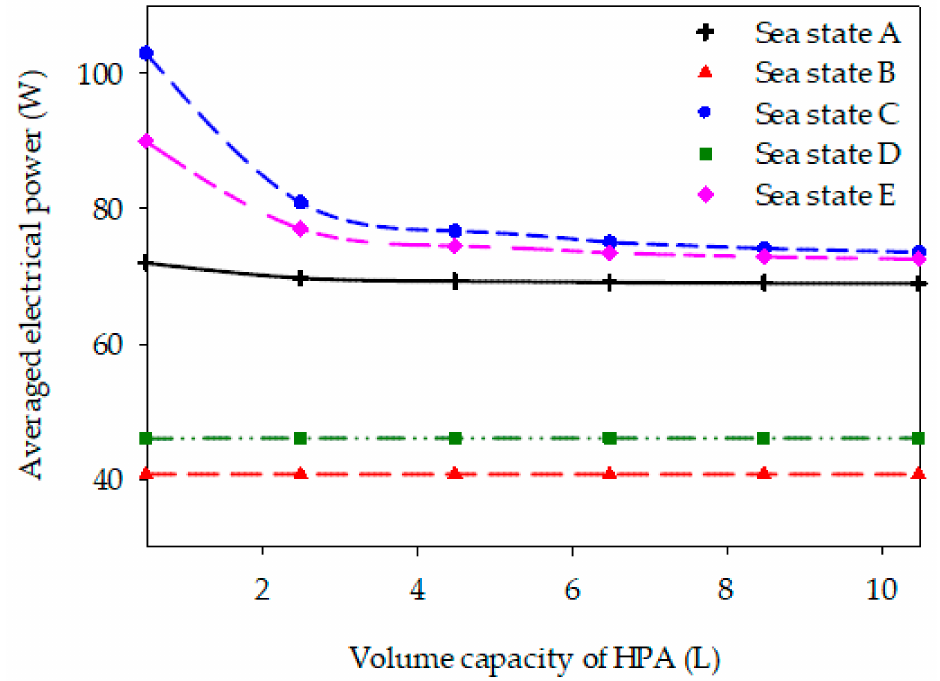
Figure 10. Averaged power of generator versus volume capacity of HPA corresponding to different sea